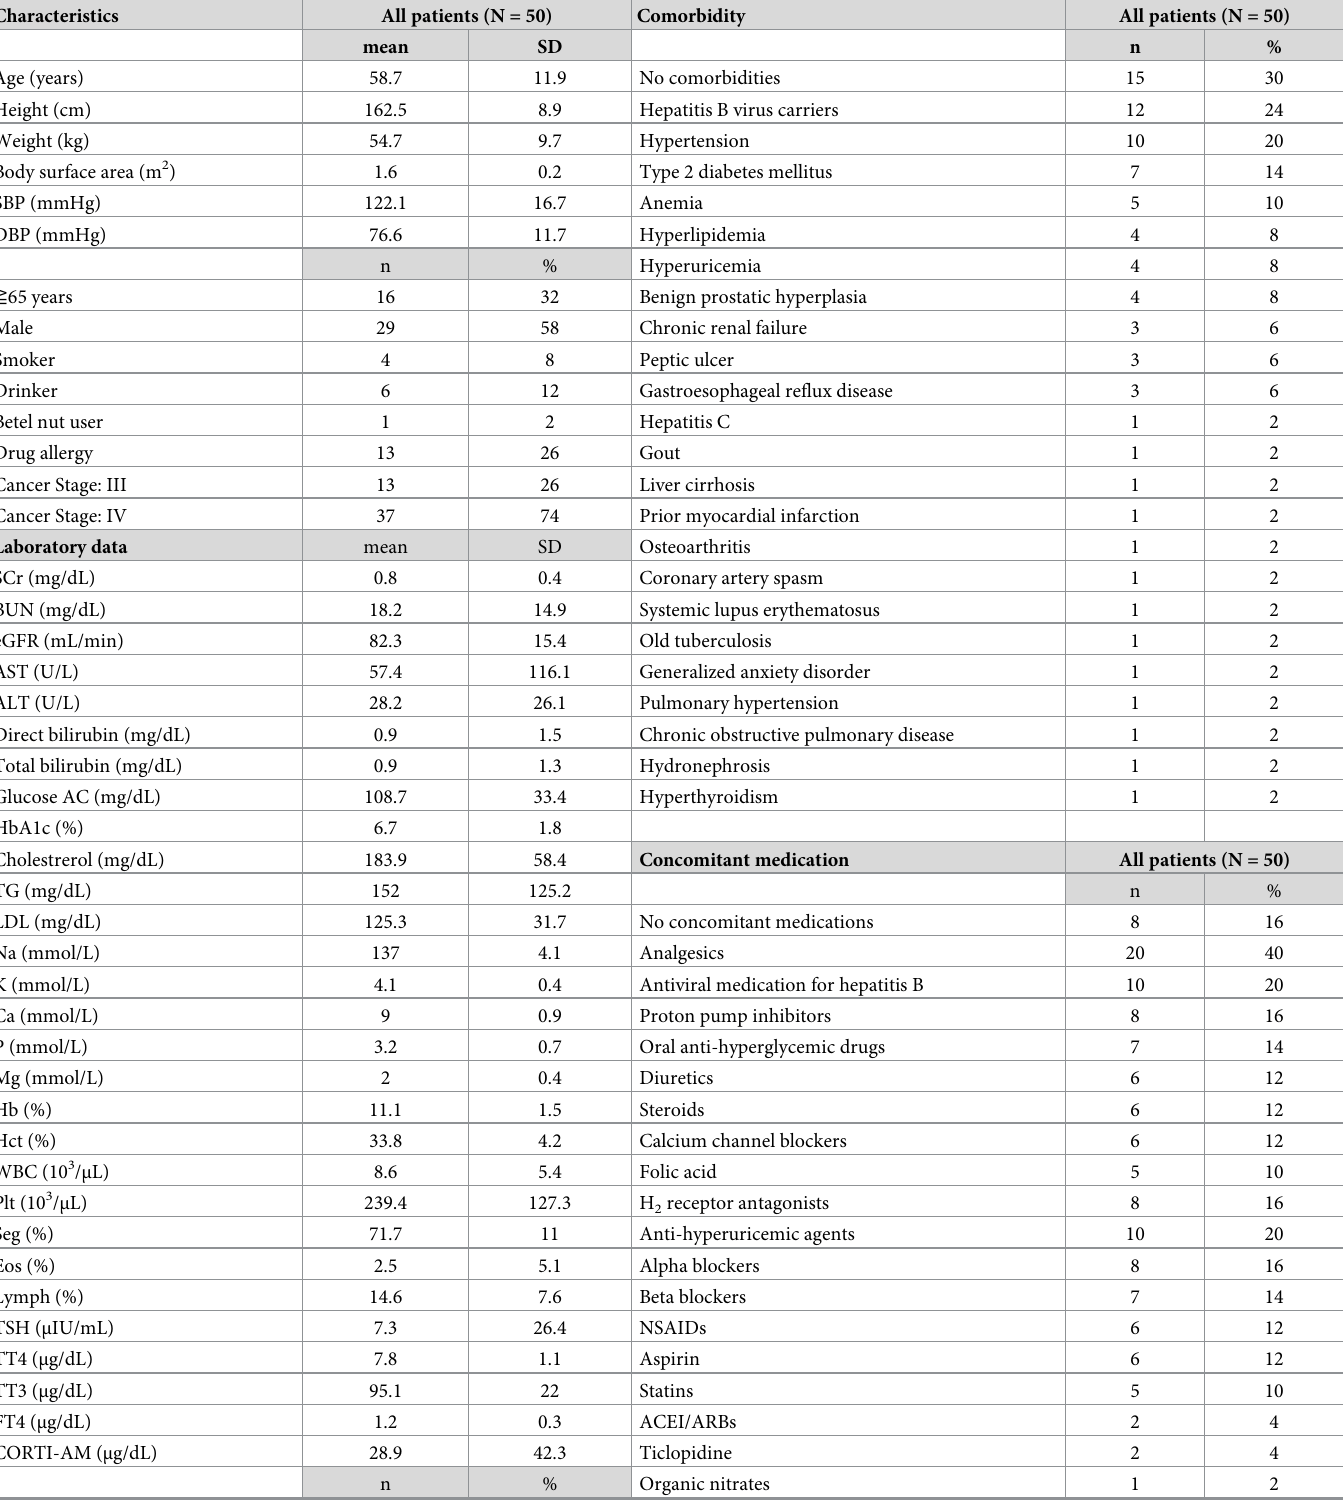
Table 1. Cohort’s characteristics.